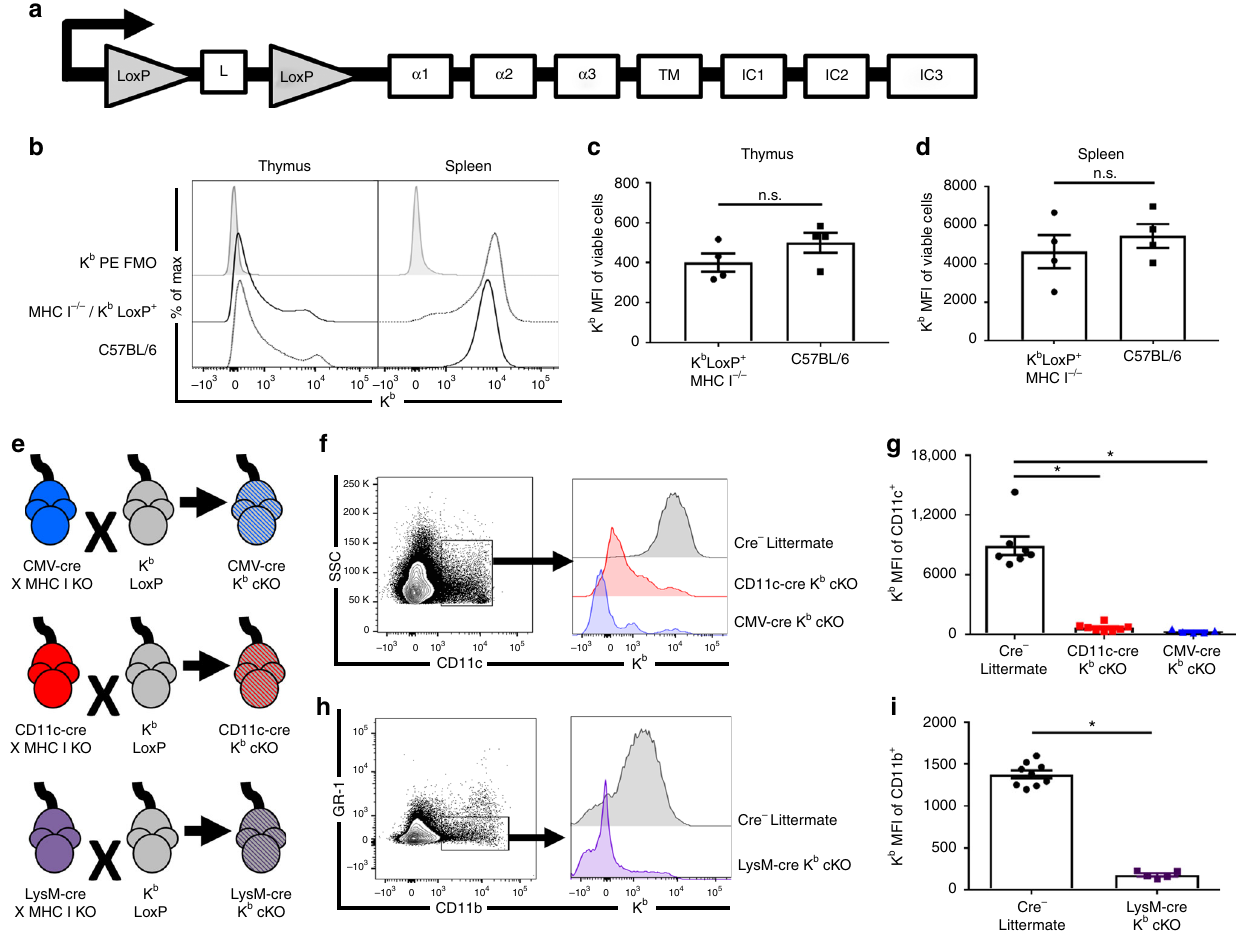
Fig. 1 Normal protein expression and ef fi cient cell-speci fi c deletion in H-2K b LoxP transgenic mice. a Diagram of the K b transgene in which the leader sequence (L) is fl anked by LoxP sites (TM: transmembrane, IC: intracellular). b Representative histograms and c and d quanti fi cation of median fl uorescence intensity (MFI) of K b on total live cells in the thymus and spleen demonstrate no difference in expression of K b derived from the transgene ( N = 4 per group). e Schematic of K b cKO crosses. f Representative histogram and g median fl uorescence intensity (MFI) quanti fi cation showing ef fi cient knockdown of K b on CD11c + dendritic cells ( N = 7, 8, 5 per group, respectively). h Representative histogram and i MFI demonstrate K b knockdown on CD11b + GR-1 − macrophages ( N = 8 and 7 per group, respectively). Data presented as mean with error bars representing standard error of the mean (SEM). * denotes p < 0.05 by Mann − Whitney U Test or one-way ANOVA with Holm − Sidak (Fig. 5a). FITC-albumin cannot cross the blood − brain barrier under normal conditions. Therefore, increased FITC-albumin in ANKA infection model of experimental cerebral malaria (ECM). the parenchyma of the brain is the result of blood − brain barrier disruption, a hallmark of lethal P . berghei ANKA infection. We observed using confocal microscopy that the blood − brain barrier was disrupted in cre-negative littermate controls and LysM-cre K b cKO mice despite a reduction in CD8 + T-cell in fi ltration in LysM-cre K b cKO mice (Fig. 5b). Conversely, CD11c-cre K b ckO